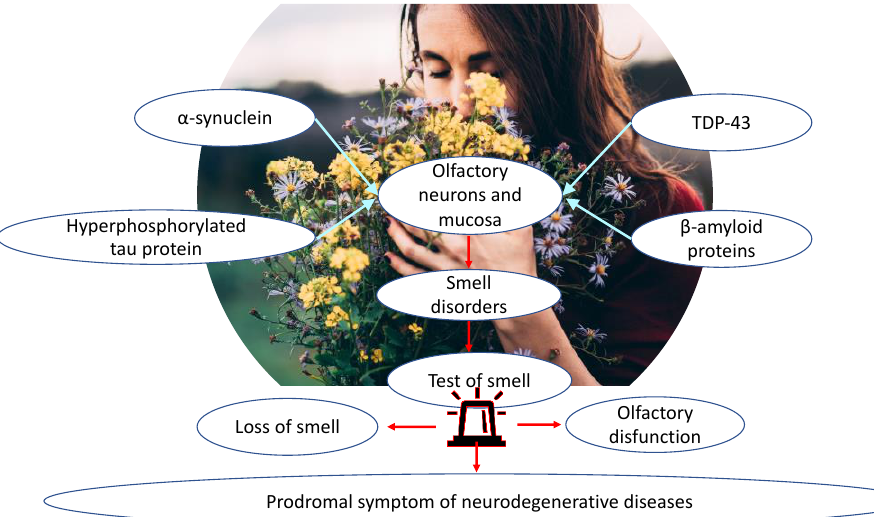
Figure 3. Higher cognitive abilities, reserved for specific brain regions, are required to identify odors, which, in neurodegenerative diseases, manifest common neuroanatomical defects, up to altered neurotransmission patterns of olfactory pathways, such as for the deposition and accumulation of molecules such as α -synuclein, TDP-43, hyperphosphorylated tau protein, and β -amyloid protein. An important aspect for the clinician, and particularly the otolaryngologist, is the performance of olfactory testing in patients who manifest olfactory disorders. In this context, individuals affected by neurodegenerative diseases should be able to perform non-cognitively complex, short-term tests with few tasks. For this reason, differential diagnosis is recommended for common nasal disorders frequently associated with anosmia or other olfactory disorders so that such disorders can be identified early, as a prodromal symptom of neurodegenerative diseases.